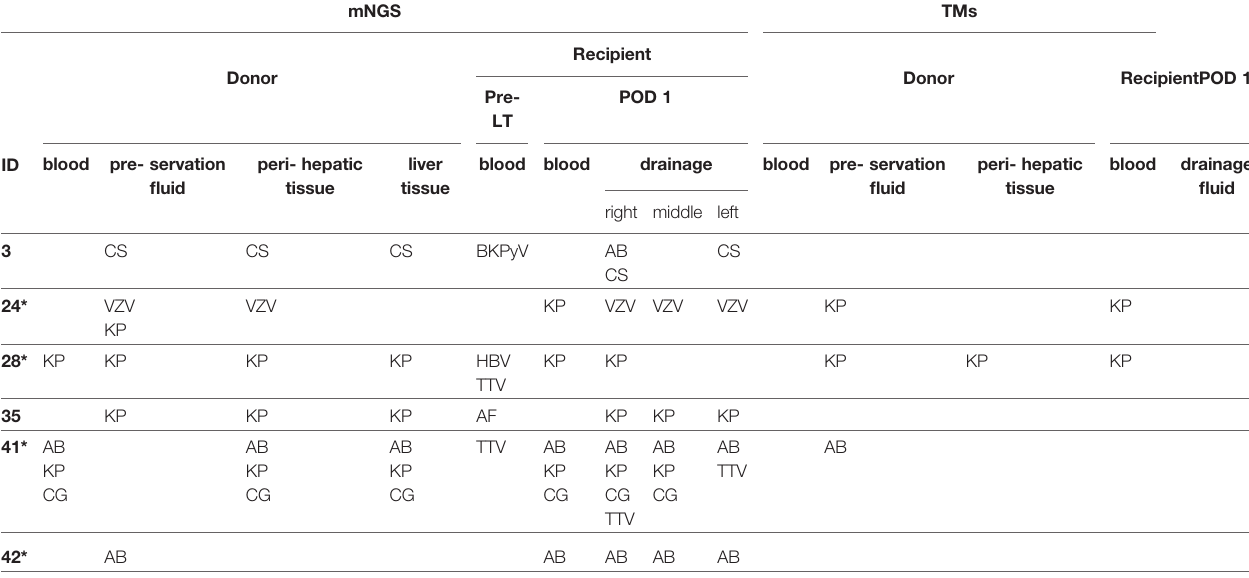
TABLE 4 | Transmission of pathogens detected by mNGS and TMs from liver donor to corresponding recipient.